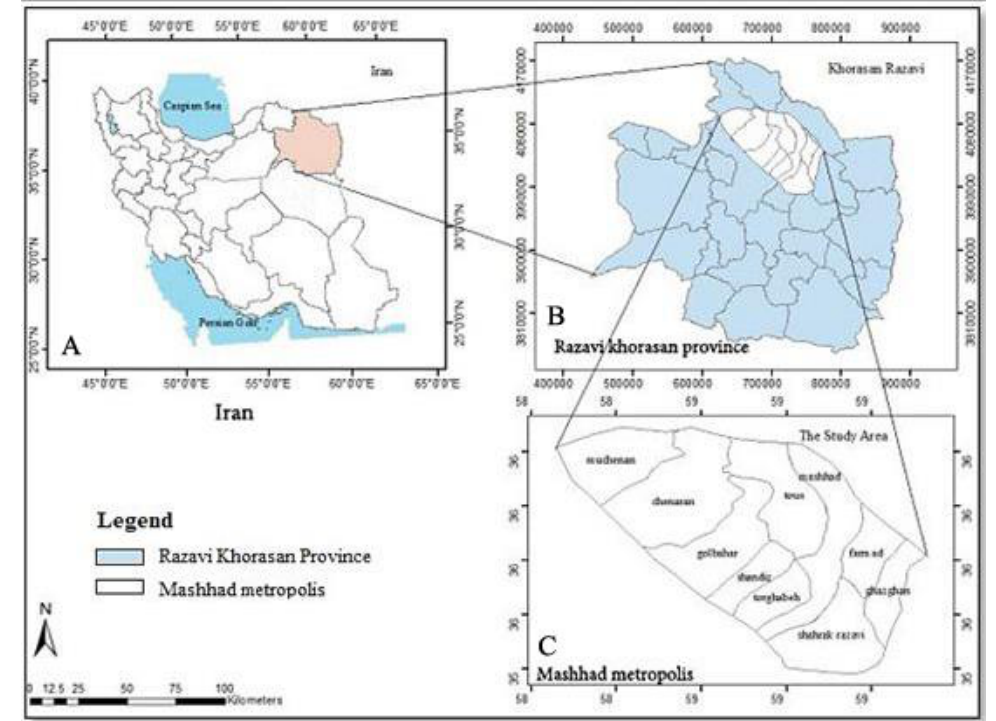
Fig. 4: location of Mashhad in Iran